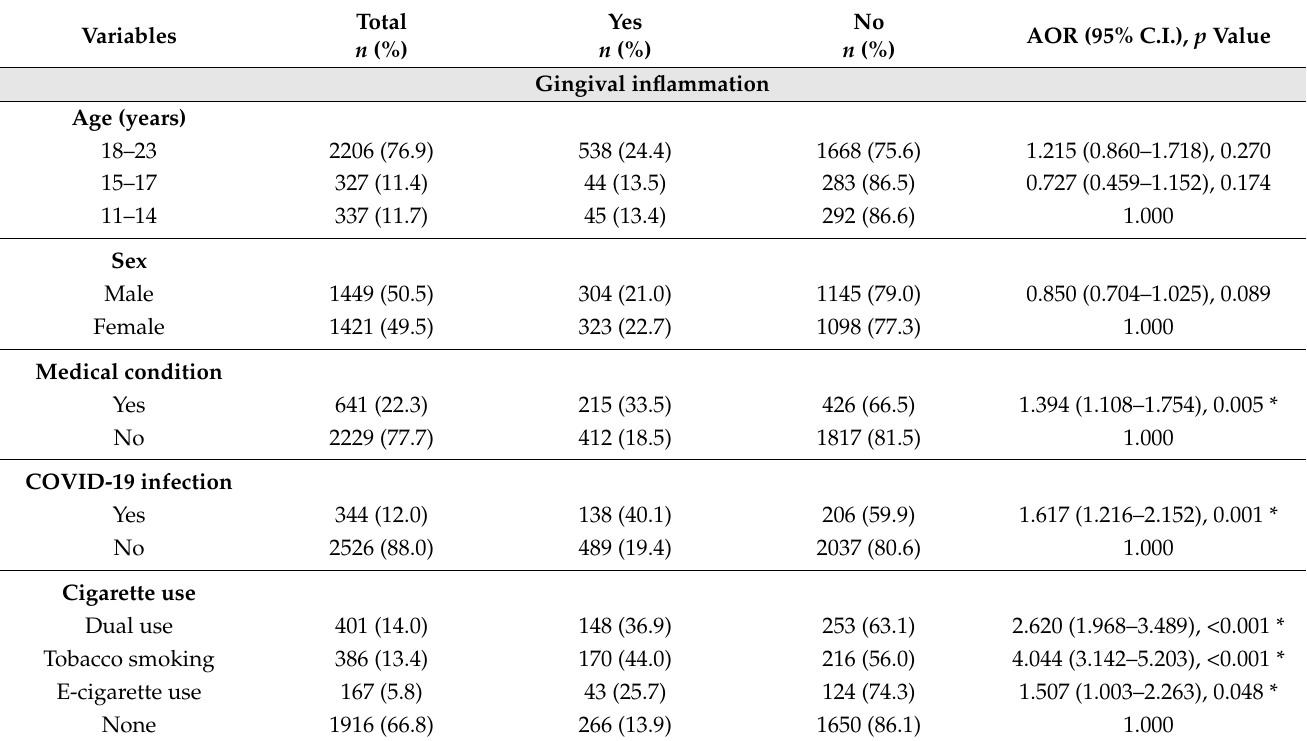
Table 1. Binary logistic regression of the association between risk indicators and oral lesions